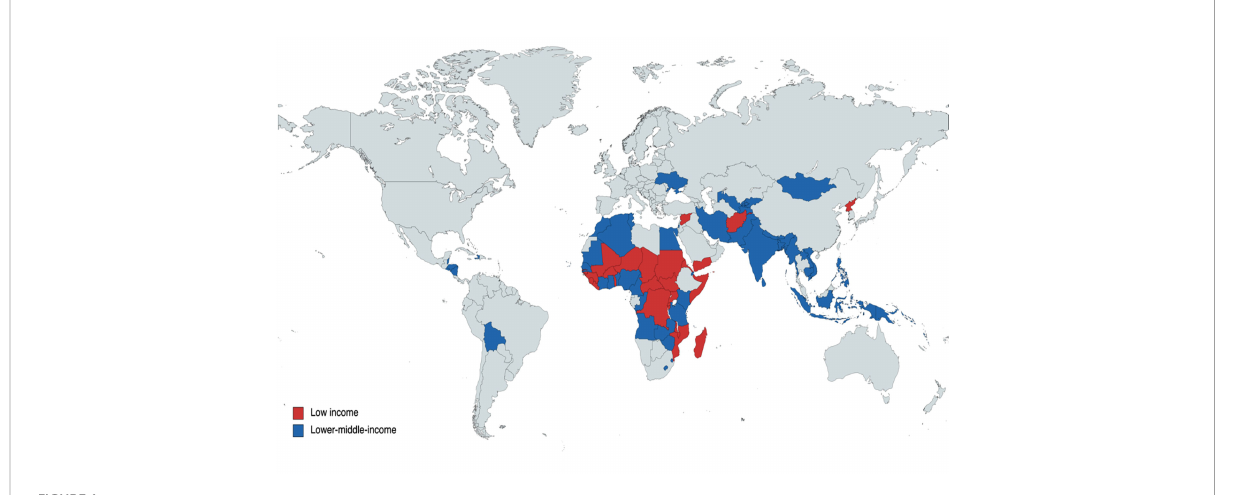
FIGURE 1 Distribution of low- and lower-middle-income countries across the